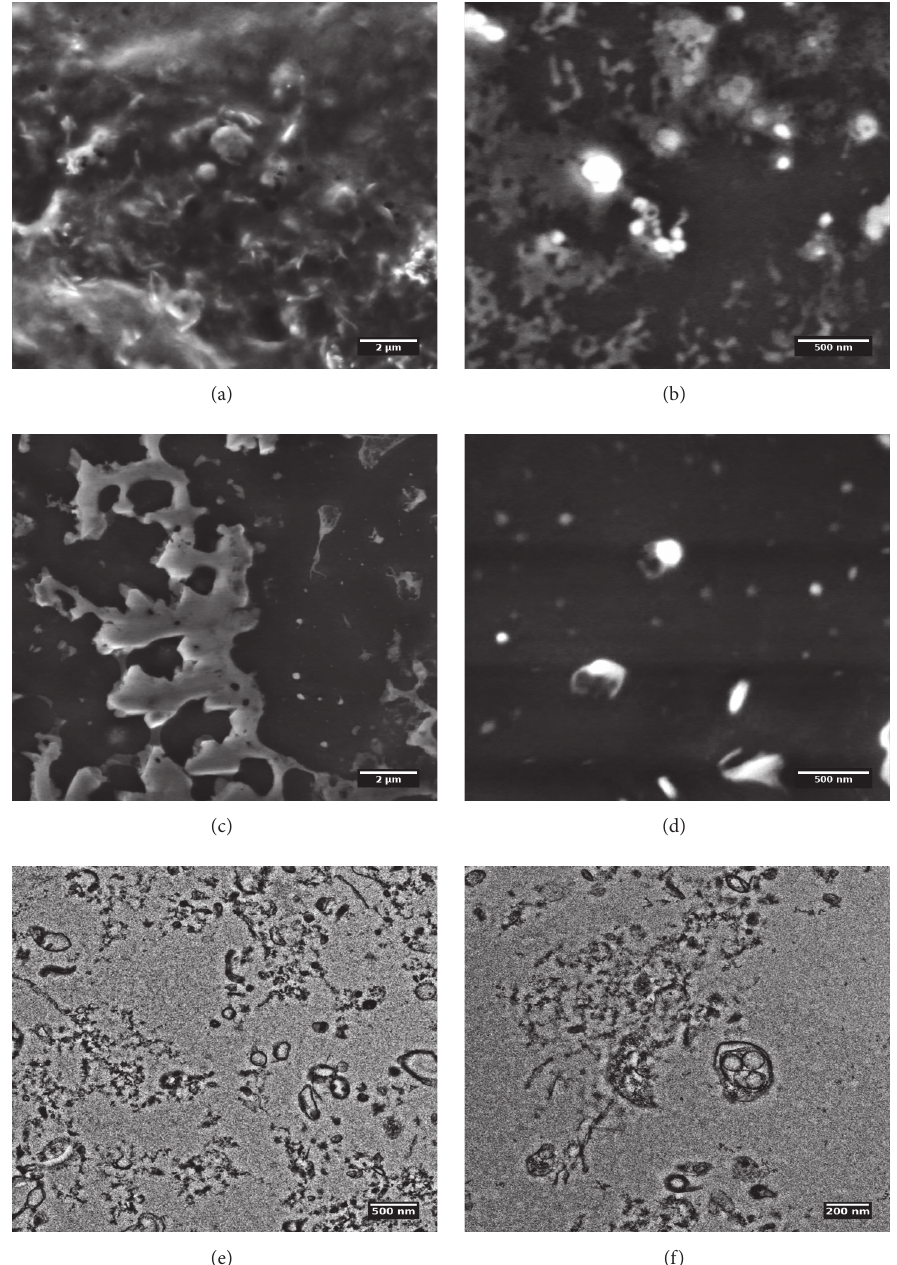
Figure 1: Environmental Scanning Electron Microscopy (ESEM) (a–d) and Transmission Electron Microscopy (e, f) images of urinary extracellular vesicles (EVs) isolated from a urine sample. ESEM images show that EVs form aggregates and they are clustered on the surface. TEM analysis visualizes the variety of different vesicle-like objects in diameter mostly around 130–160nm. Interestingly, multivesicle objects were also present in urine that confirms integrity of EVs during